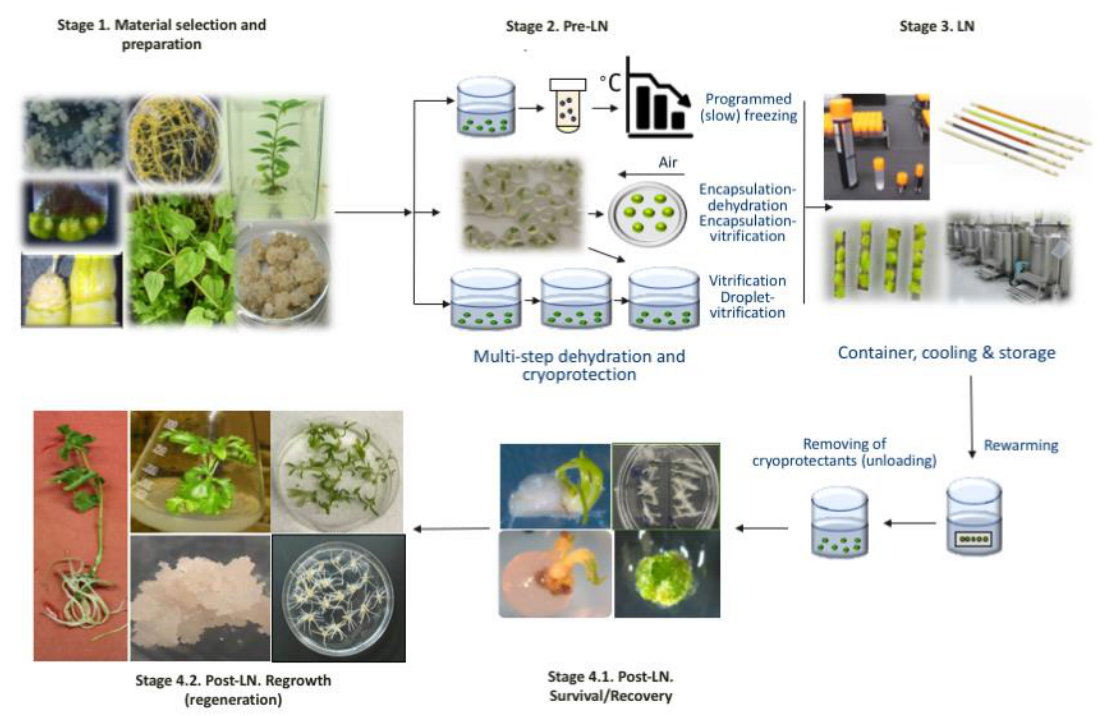
Figure 1. Schematic illustration of the cryopreservation process for in vitro plant germplasm.